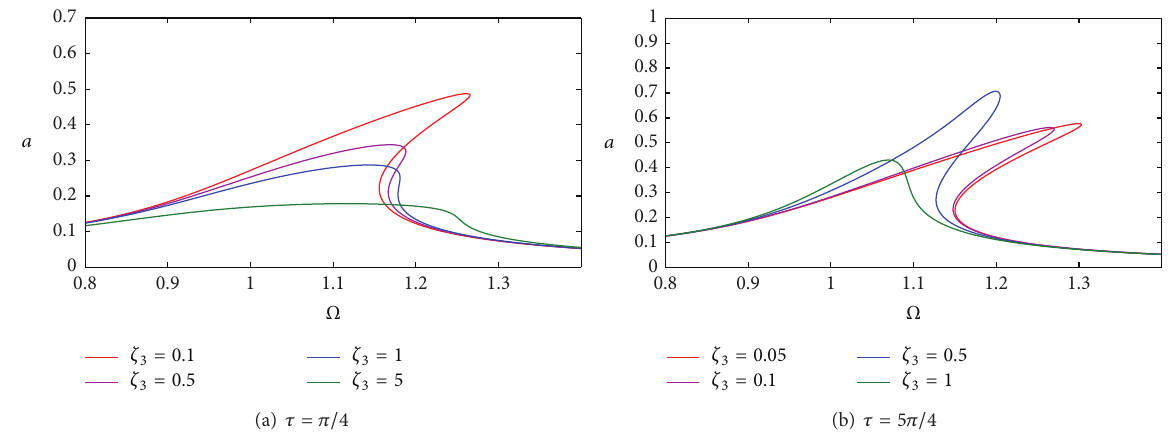
Figure 6: Amplitude-frequency relationships of the primary resonance for the controlled system with different feedback gain 𝜁 3 ( 𝜁 1 = 0.025 , = 0.05 , 𝑘 = 1 , and ̂ 𝜆 = 0.4 𝑓 1